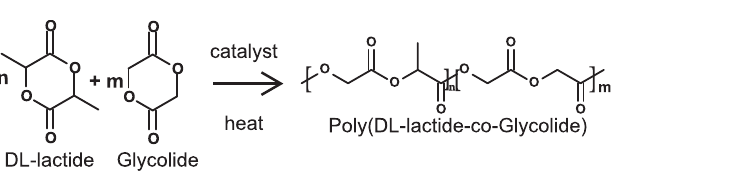
Fig 1. Biopolymers formulation based on PLA and glycolic acid (Courtesy: PURAC-CORBION, 2010).